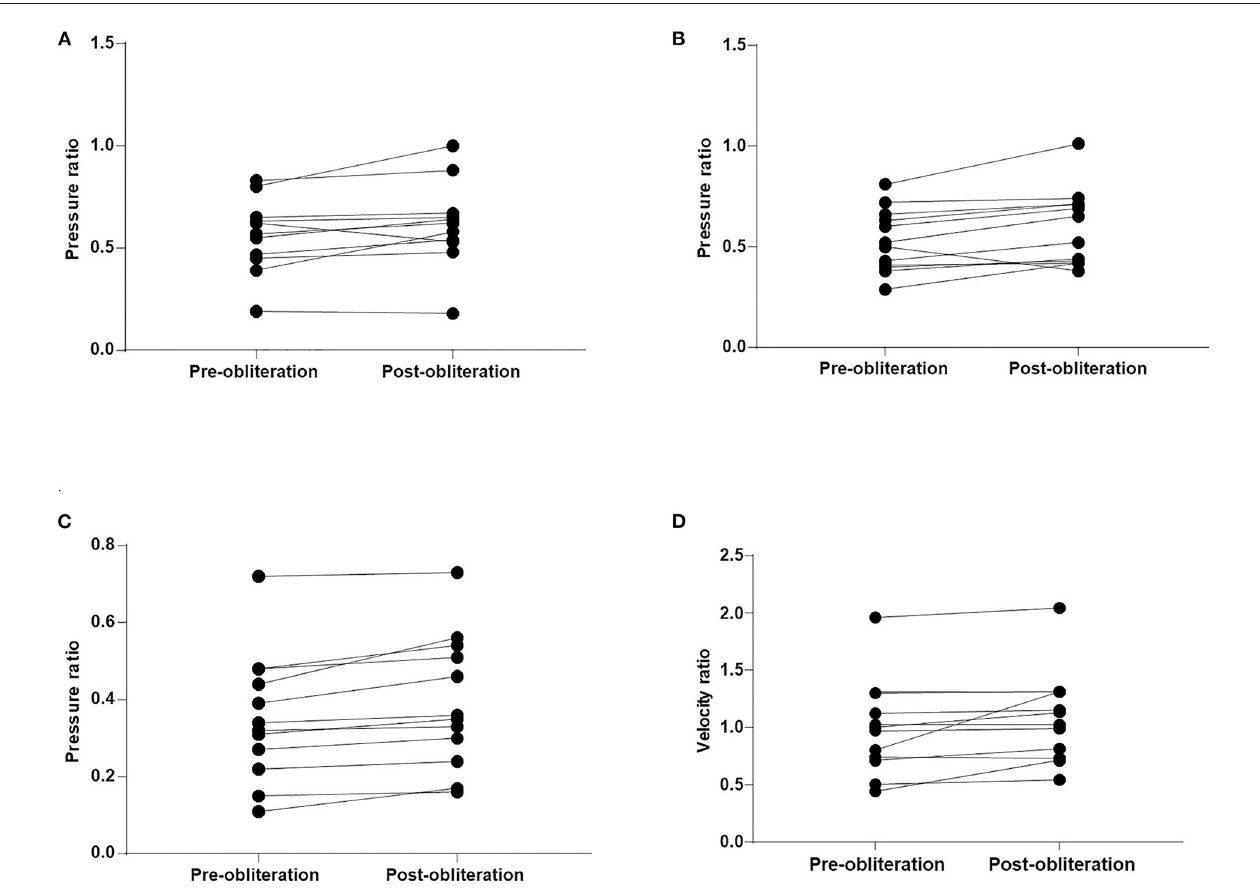
FIGURE 2 | Comparison of the pressure ratio and velocity ratio after obliteration of aneurysms. (A) A1 segments. (B) M1 segments. (C) M2 + M3 segments. (D) M2 + M3 segments.